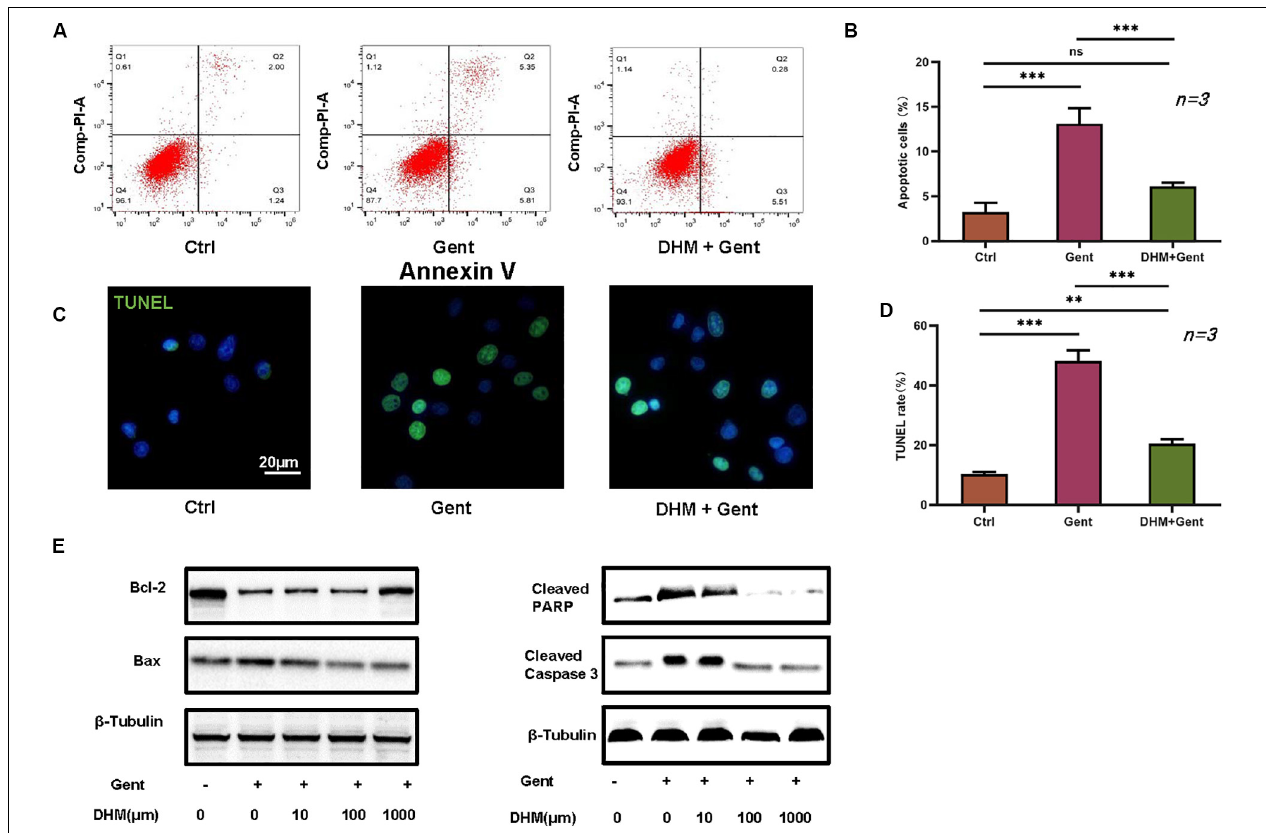
FIGURE 2 | DHM attenuates gentamicin-induced HEI-OC1 cell apoptosis. (A,B) HEI-OC1 cells were divided into three groups: Ctrl (no treatment), Gent (500 µ M gentamicin treatment for 12 h), and DHM + Gent (1,000 µ M DHM pretreatment for 24 h and gentamicin treatment for 12 h). Apoptotic cells were detected by flow cytometry. (C,D) Quantitative analysis of TUNEL-positive cells. Scale bar, 20 µ m. (E) Western blot analysis of B-cell lymphoma 2-associated X protein (Bax), cleaved caspase-3, and cleaved PARP expression as a function of DHM concentration. β -Tubulin was used as a loading control. Experiments were repeated three times. NS, not significant; ∗∗ P < 0.01, ∗∗∗ P < 0.001 (1-way analysis of variance followed by Tukey’s multiple comparisons test).